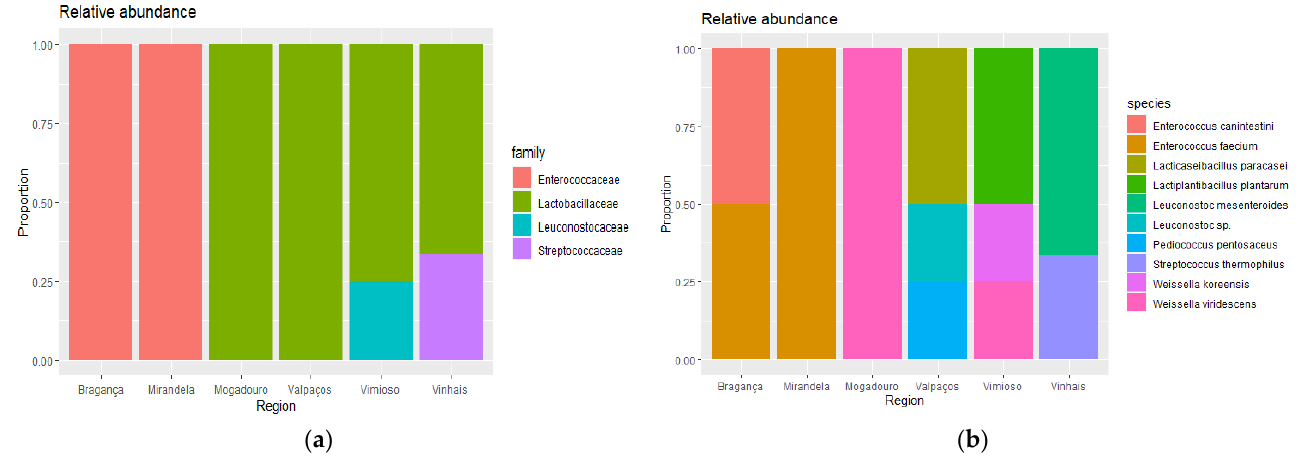
Figure 1. Relative abundance of lactic acid bacteria isolated from alheira sausages per region at ( a ) the family level and ( b ) the species level.